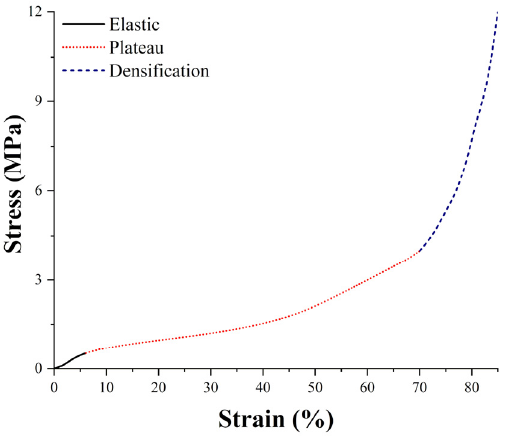
Figure 2. Typical stress–strain compressive curve of cork. Table 2. Chemical composition of